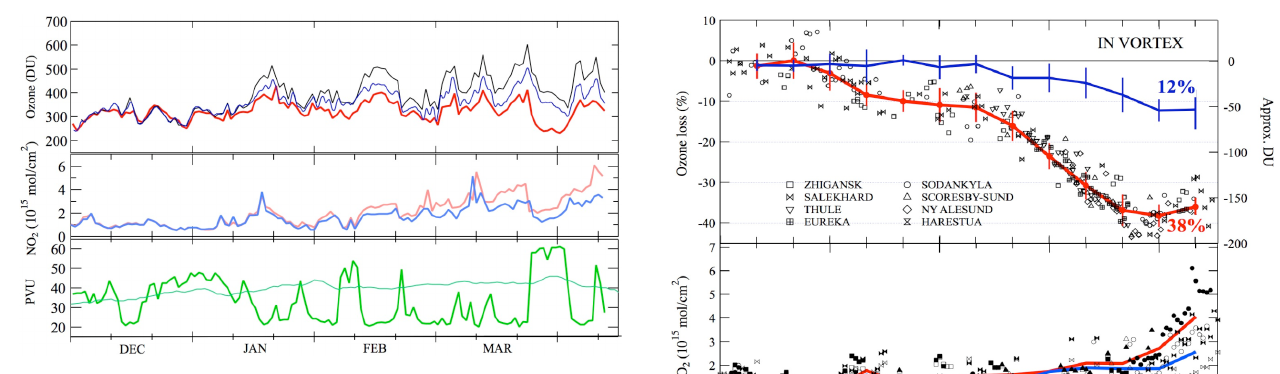
Fig. 1. SAOZ measurements in Sodankyl¨a from 1 December 2010 Figure 1. SAOZ measurements in Sodankyla from December 1, 2010 to April 15, 2011. From to 15 April 2011. From top to bottom: SAOZ total ozone (red) com-